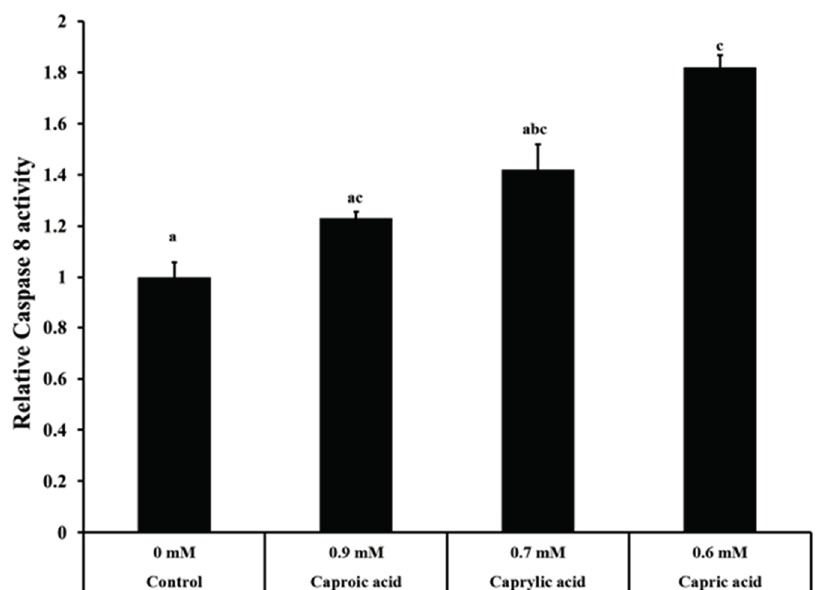
Figure 3. Effect of goat milk medium chain fatty acids on caspase-8 activity in human colorectal carcinoma cells. The HCT-116 cells were treated with capric (0.60 mM), caprylic (0.70 mM) or caproic acids (0.90 mM) for 24 h. After 24 h, caspase 8 activity was determined using caspase-8 fluorimetric assay. Bars marked with letters (a, b, c) are significantly different at p <